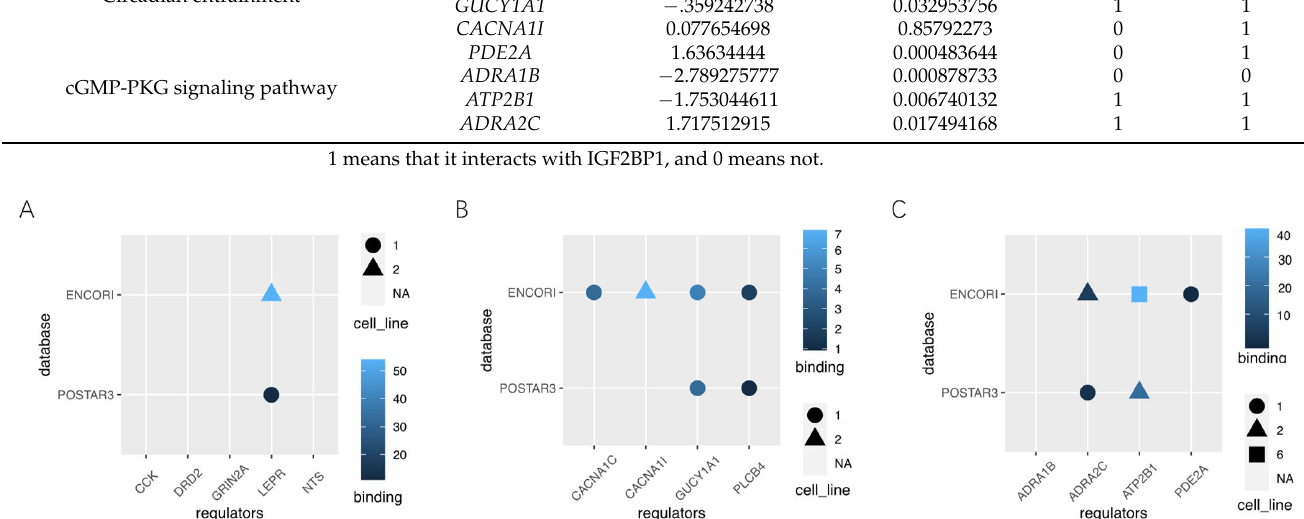
Table 2. mRNA expression level of m6A regulatory factor in LHb.